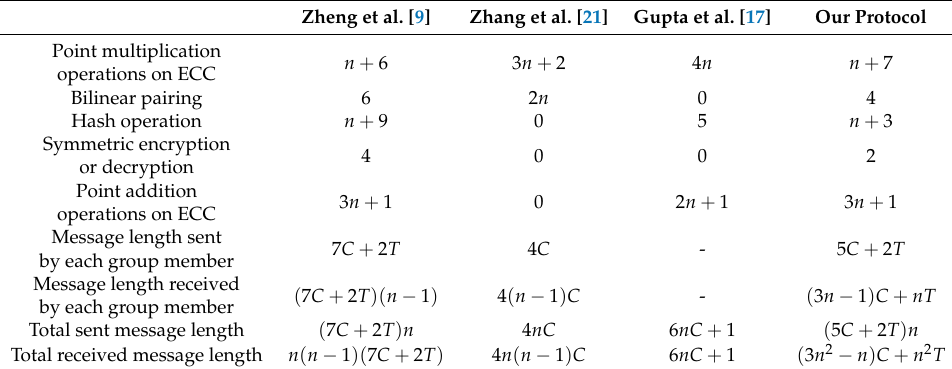
Table 2. The comparison of computation cost and communication cost between our protocol and related